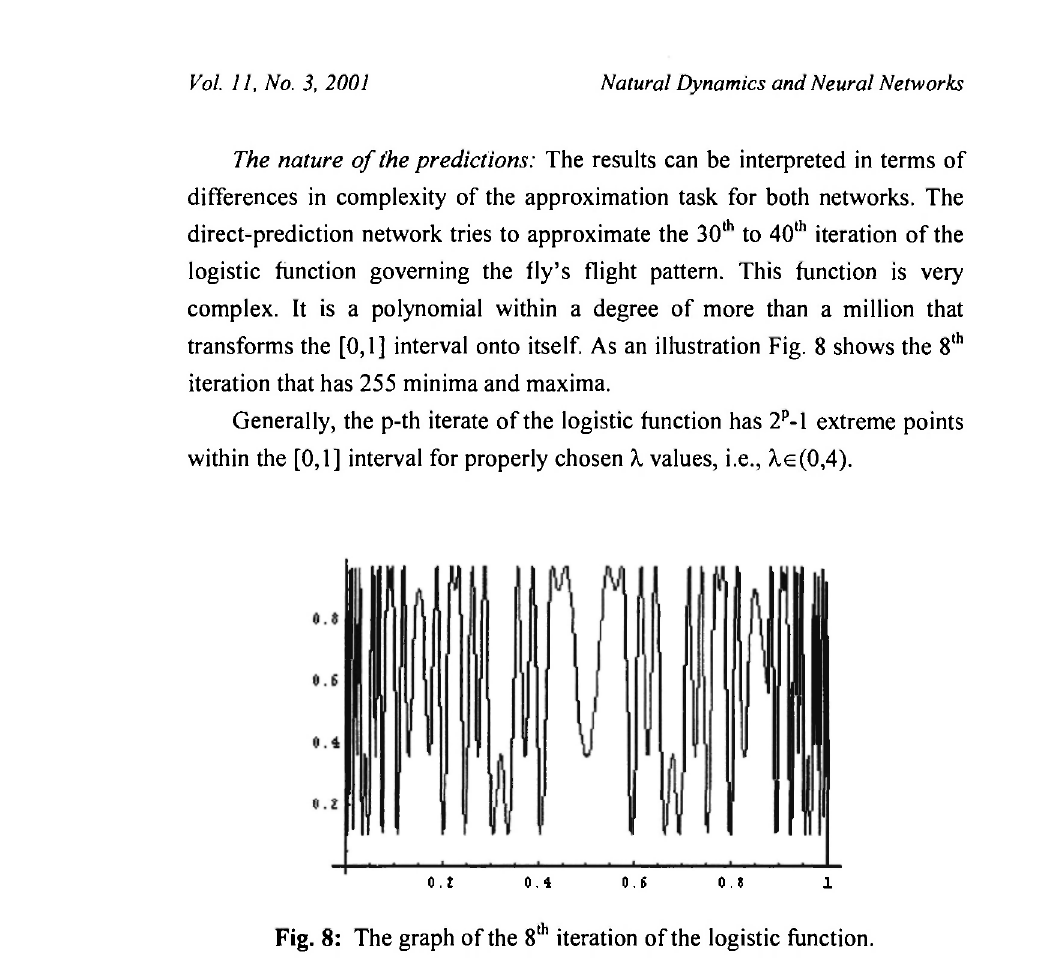
Fig. 9: The graph of the logistic